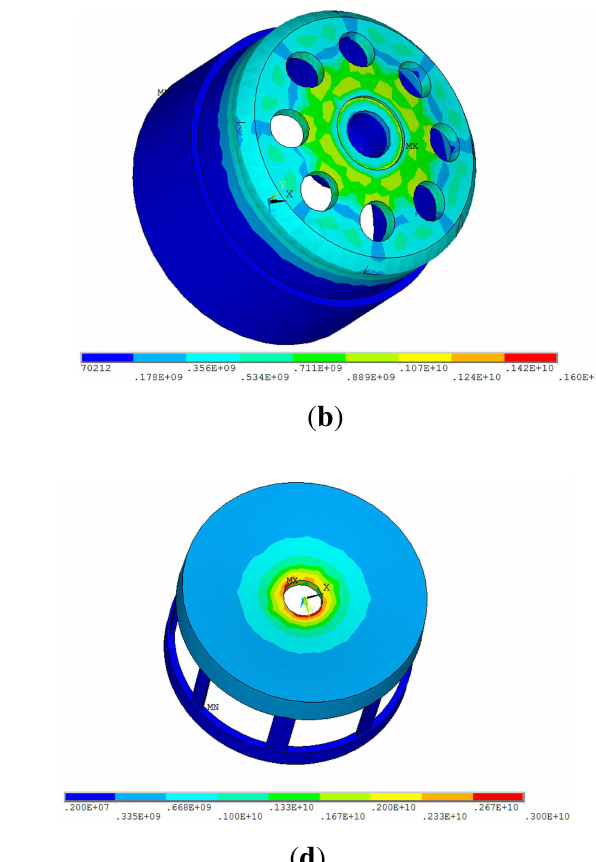
Figure 14. The stress cloud charts under 20,000 x g. ( a ) Stress Cloud Charts of BVG. ( b ) Stress Cloud Charts of Cylinder Vibratory Gyro. ( c ) Stress Cloud Charts of Hemispherical Resonator Gyro. ( d ) Stress Cloud Charts of Novel Ring Vibratory